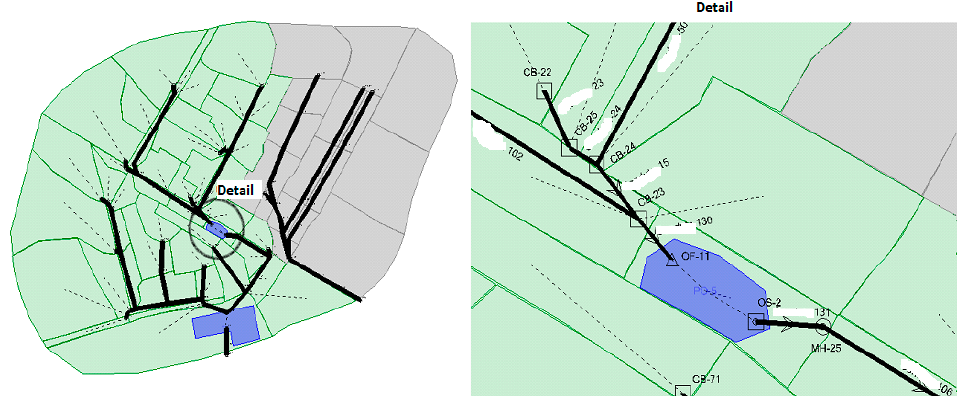
Figure 8. Combination of a retention pond and blocks of storage.